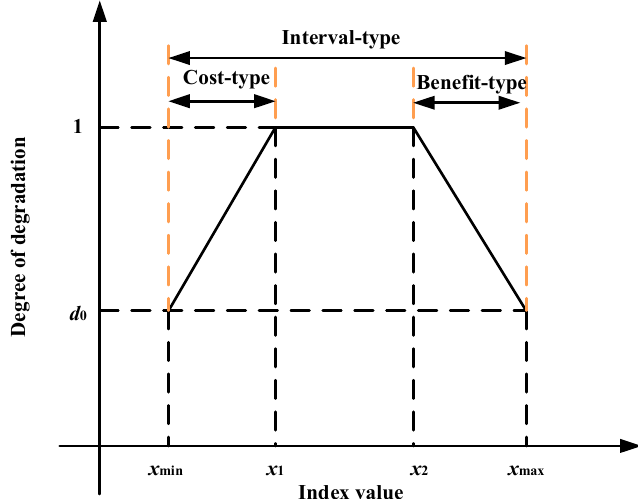
Figure 4. Degradation calculation of different types of indicators.